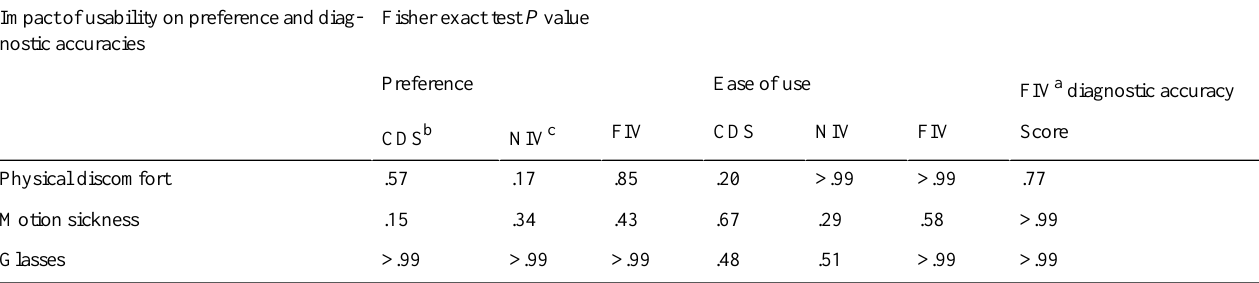
Table 8. Preference and ease of use ratings and diagnostic accuracy using the full-immersive virtual reality display system between the groups with and without physical discomfort, motion sickness, and eyeglass use.